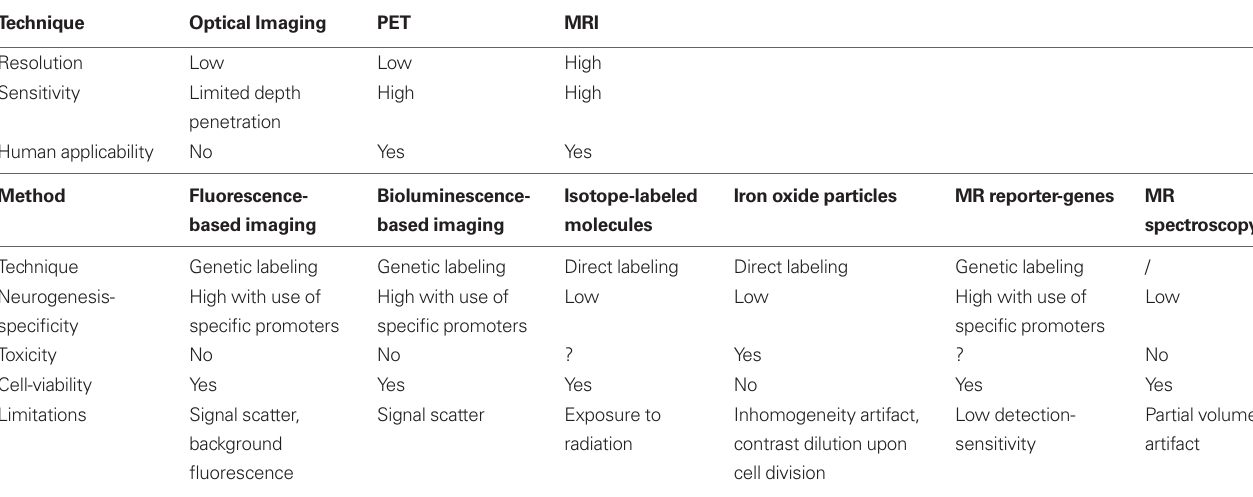
Table 1 | Comparison of various imaging methods for in vivo monitoring of adult neurogenesis.